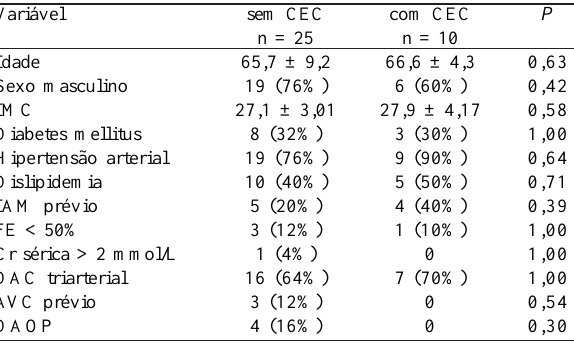
Tabela 1. Dados demográficos e parâmetros clínicos pré- operatórios